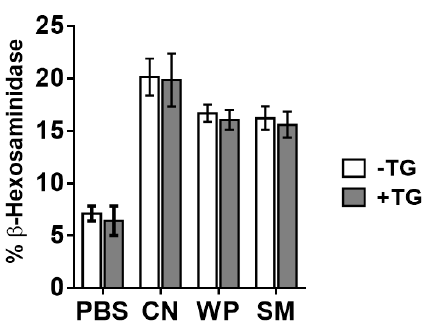
Figure 3. Mast cell degranulation capacity. Measurement of β -hexosaminidase release induced by casein (CN), whey proteins (WP) and skim milk (SM), either untreated (white bars) or treated with TG (grey bars), after sensitization of bone marrow derived mast cells with sera from CN, WP and SM allergic mice, respectively. Data are expressed as mean ± SEM of 3 different experiments.